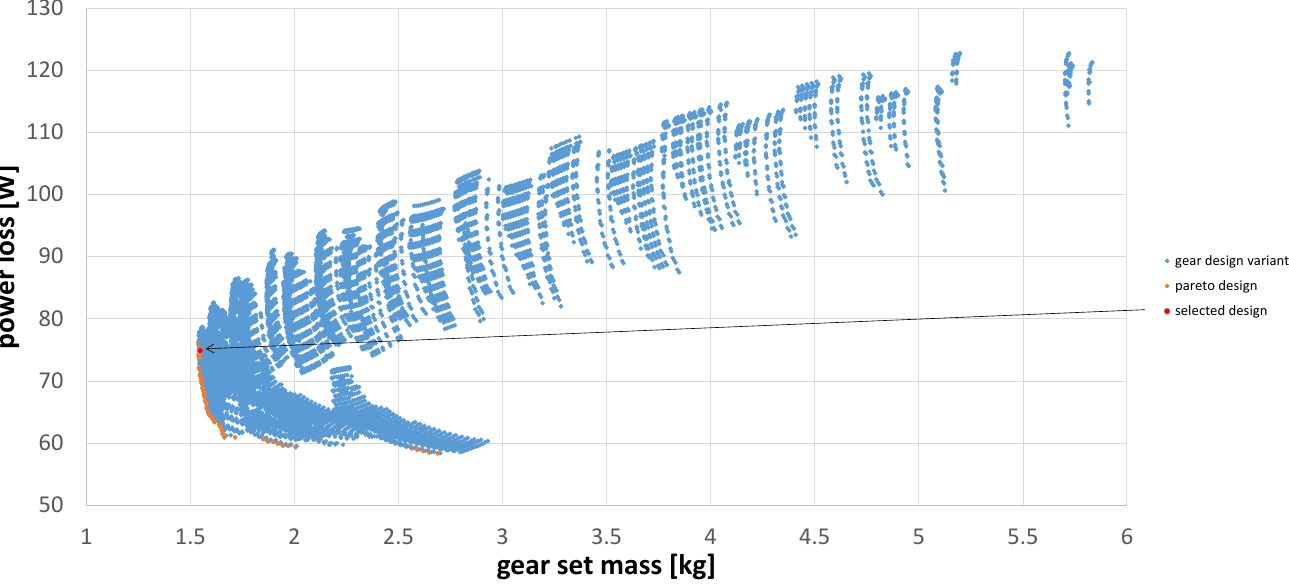
Figure 14. Design exploration and its evaluation according to power loss and gear set